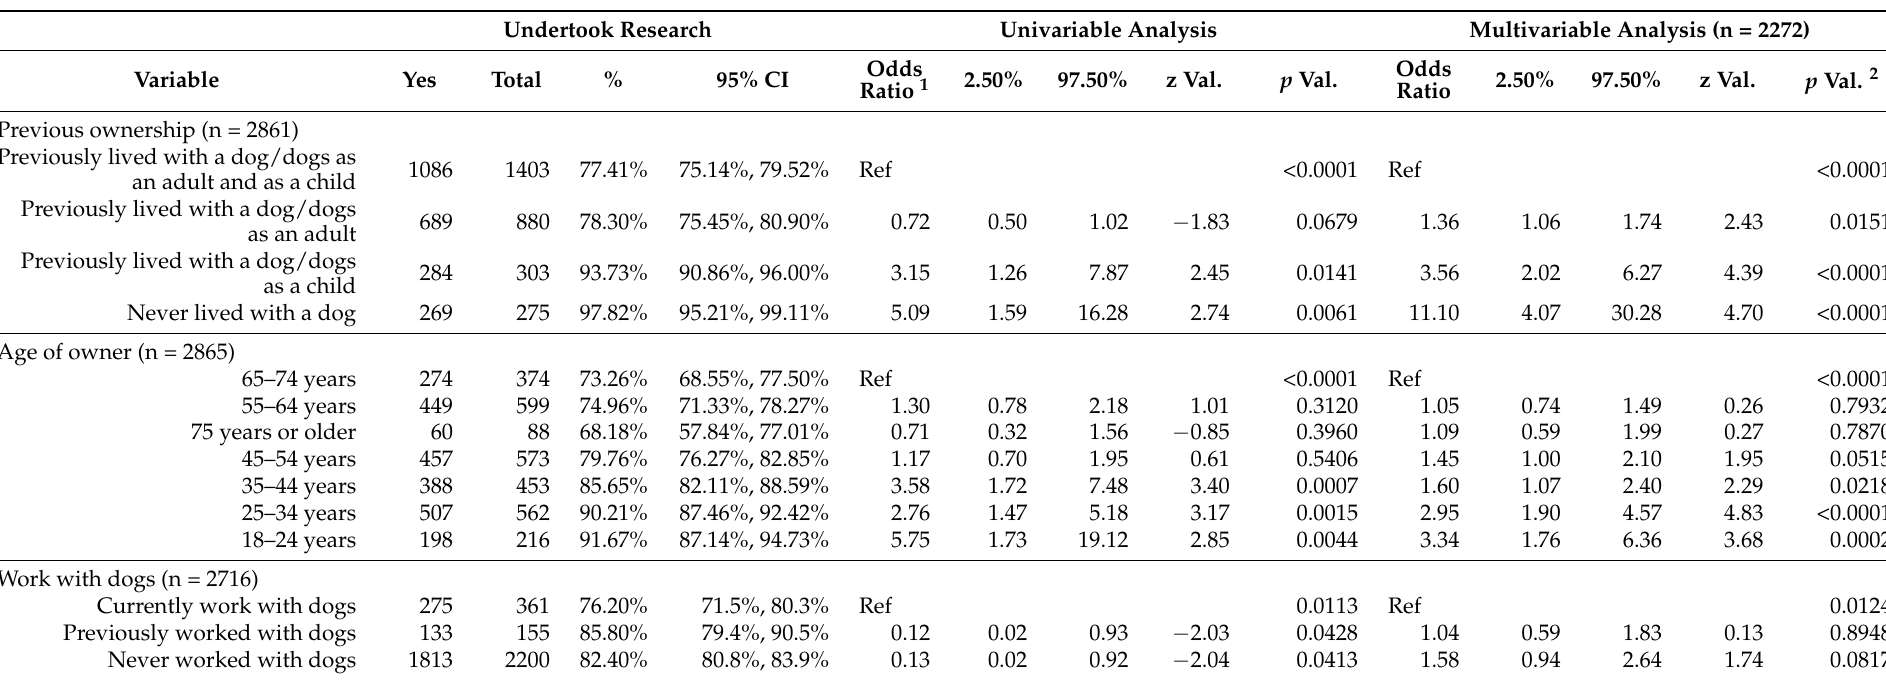
Table 2. Multivariable analysis of factors that affect whether research was undertaken prior to acquiring a dog for potential owners (multivariable analysis n = 2272; univariable analyses n are given for each